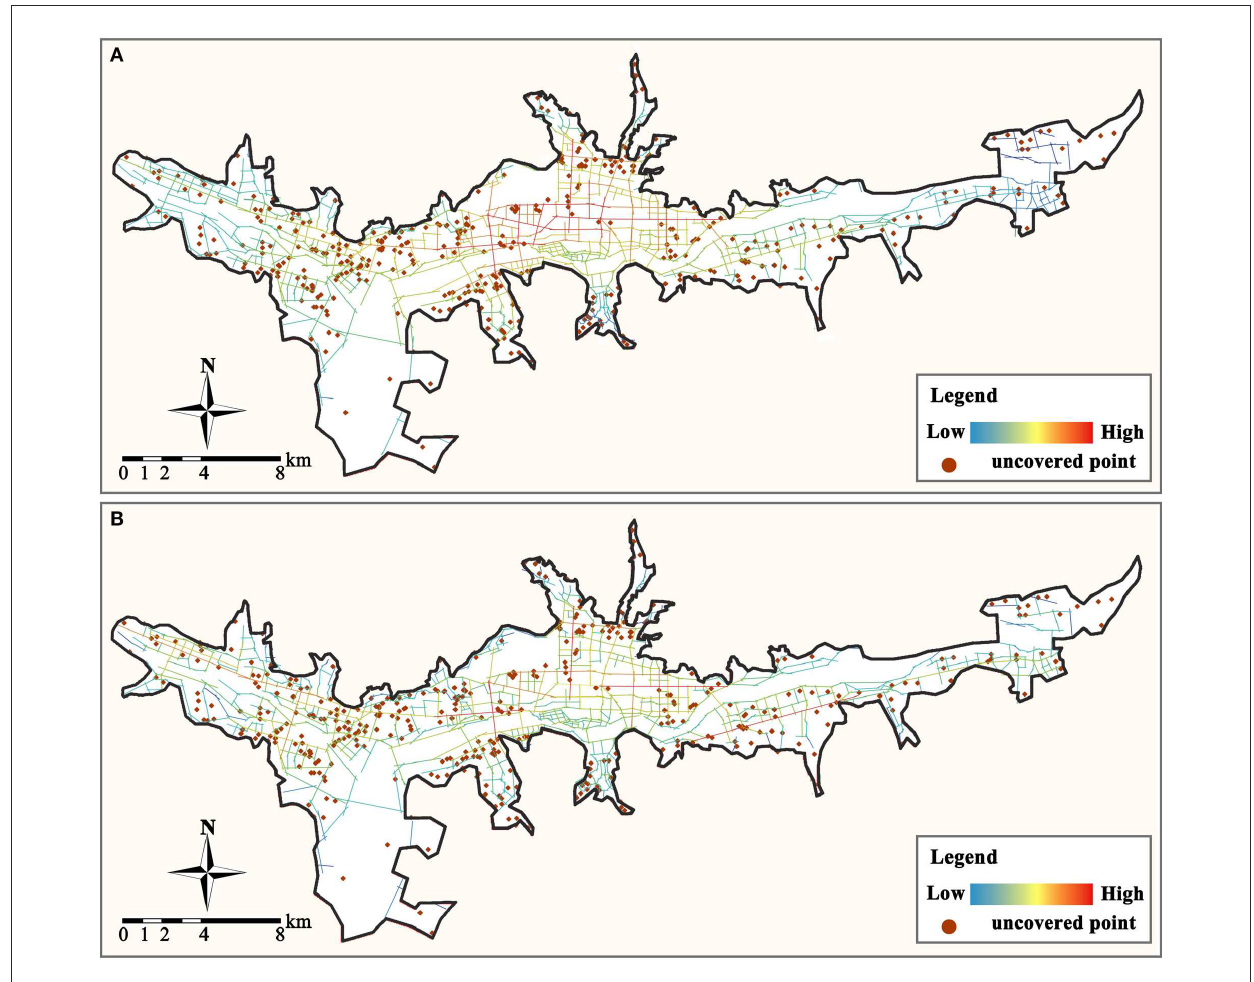
FIGURE7 Analysis of urban road axis integration. (A) Global integration. (B) Local